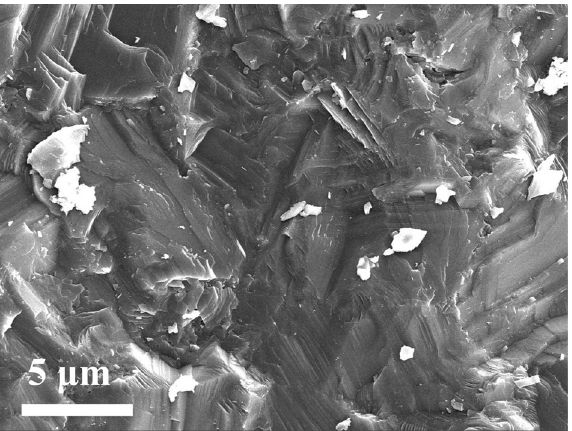
Figure 5. SEM Fracture Surface. SEM image of the fracture surface of the CFPDC material showing transgranular fracture failure mode, clearly demonstrating extreme strong diamond to diamond bonding.